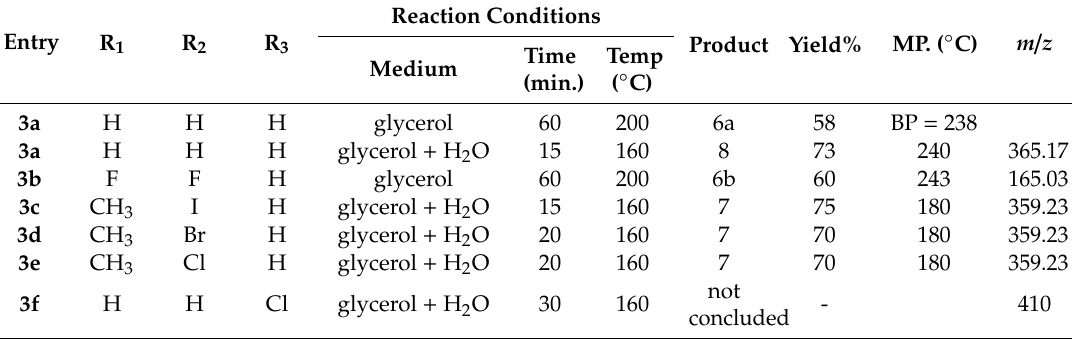
Table 1. Variation of the nature of aniline products depending on the reaction conditions in the presence and absence of H 2 O, starting from glycerol 1 under a high pressure, and high temperatures in the